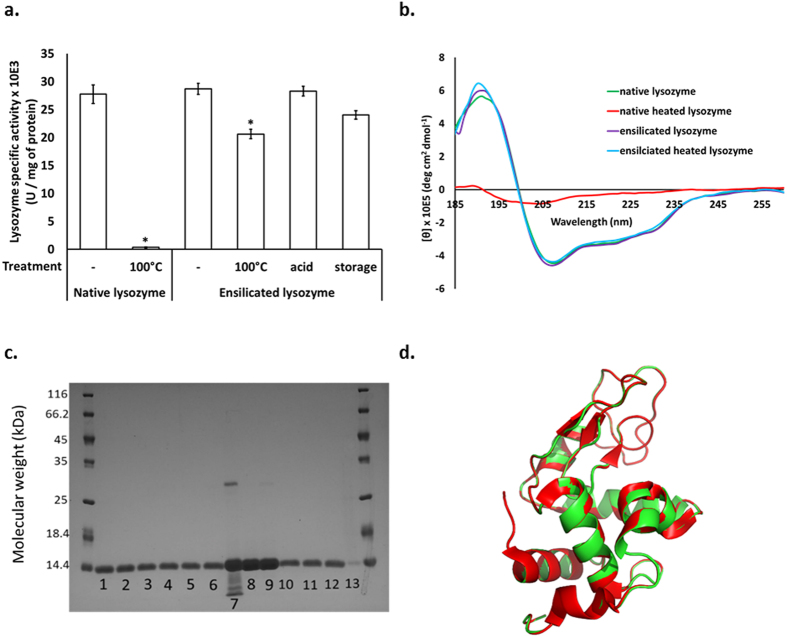
Characterisation of the ensilicated and released lysozyme.(a) Specific activity of lysozyme protein before and after ensilication. Ensilicated lysozyme powder was treated by heating at 100 °C for 5 h, by incubating in 10 M HCl for 3 h, or stored at 22 °C for 6 months. At the end of the treatment, the ensilicated lysozyme was released and the lysozyme activity measured. Data are mean values and SEM, n = 3, *p < 0.05. (b) CD spectra for lysozyme (green - native lysozyme; red - native heated lysozyme; purple – ensilicated lysozyme; blue - ensilicated heated lysozyme). (c) SDS-PAGE analysis of lysozyme. Lanes 1–3: ensilicated lysozyme (3 individual preparations), Lanes 4–6: ensilicated heated lysozyme (3 individual preparations), Lane 7: heated native lysozyme solution, Lane 8: native lysozyme solution (a control), Lane 9: dry-heated lyophilised lysozyme, Lanes 10–12: ensilicated acid treated lysozyme (3 individual preparations), Lane 13: supernatant after ensilication. (d) Ribbon diagram of the crystal structure of the released lysozyme (green) superimposed onto a published structure of the protein (red; PDB code 2w1x). Rmsd overall 0.09 Å. Rmsd individual amino acids 0.24 Å.